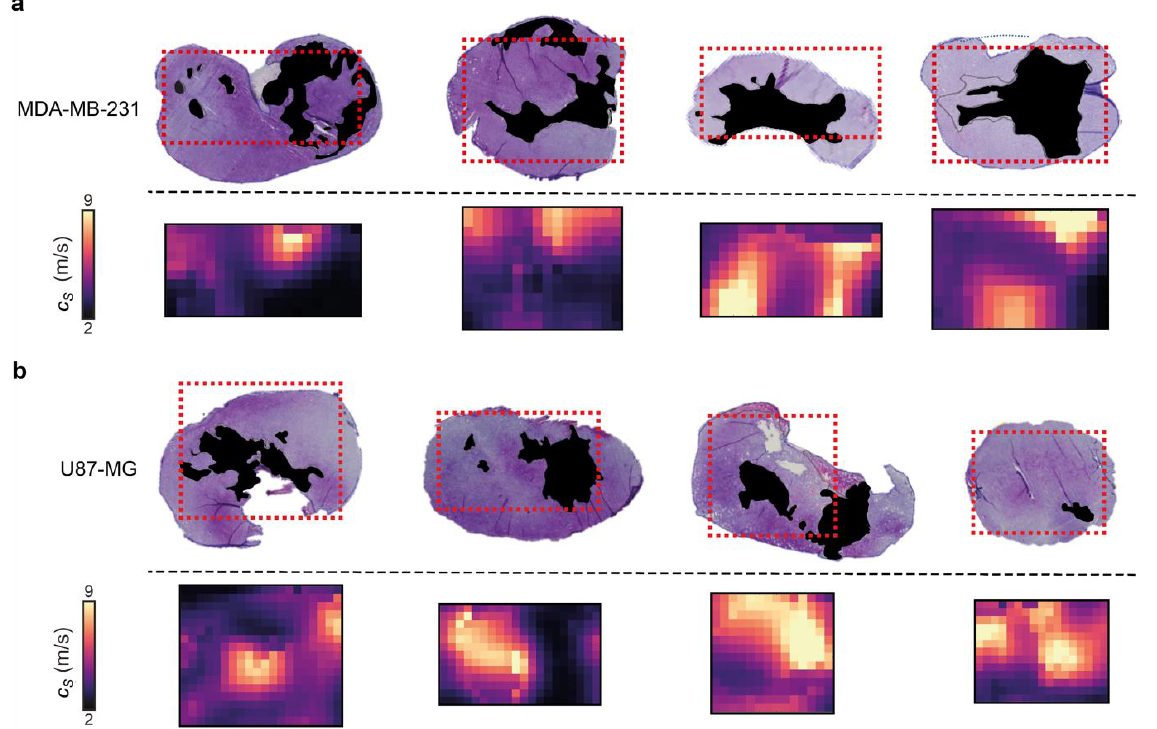
Figure 4. Comparison of 3D-VSWE derived parametric maps of shear wave speed c s with aligned haematoxylin and eosin-stained histological sections. ( a ) shows MDA-MB-231 and ( b ) shows U-87 MG vehicle tumours. Necrotic regions in the tissue micrographs have been coloured black; in the c s maps, the corresponding necrotic regions tend to have low c s , represented by dark purple and black. The spatial distribution of necrotic and viable tissue in vehicle tumours reveals that VSWE provides a good representation of the heterogeneous viable versus necrotic tissue within the tumour. Note that excised tissues are subject to shrinkage/deformation associated with pathological processing. Further, c s maps are the central plane of the 3D data, which represents a 2 mm thick slice of tissue, whereas histological sections were about 8 µ m thick. This may lead to partial volume effects; necrotic foci can have irregular distribution, i.e., tissue within one 8 µ m slice may not give a good representation of tissues that lie at a distance on the order of a